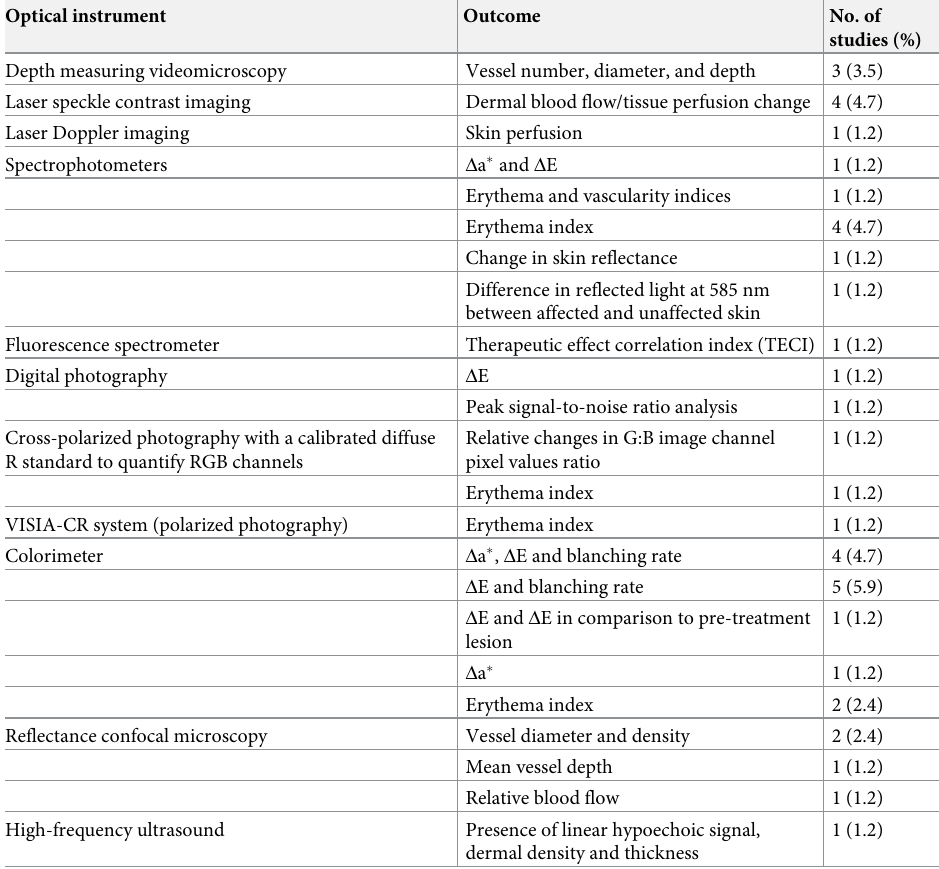
Table 3. Outcomes of objective